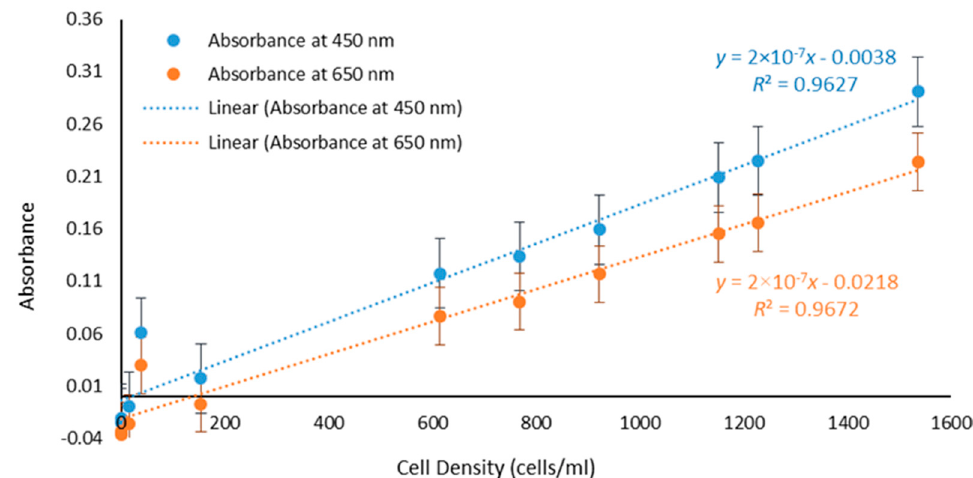
Figure 3. Linear increase in the value of the Absorbance with cell density at 450 nm ( R 2 = 0.9627) and 650 nm ( R 2 = 0.9672).